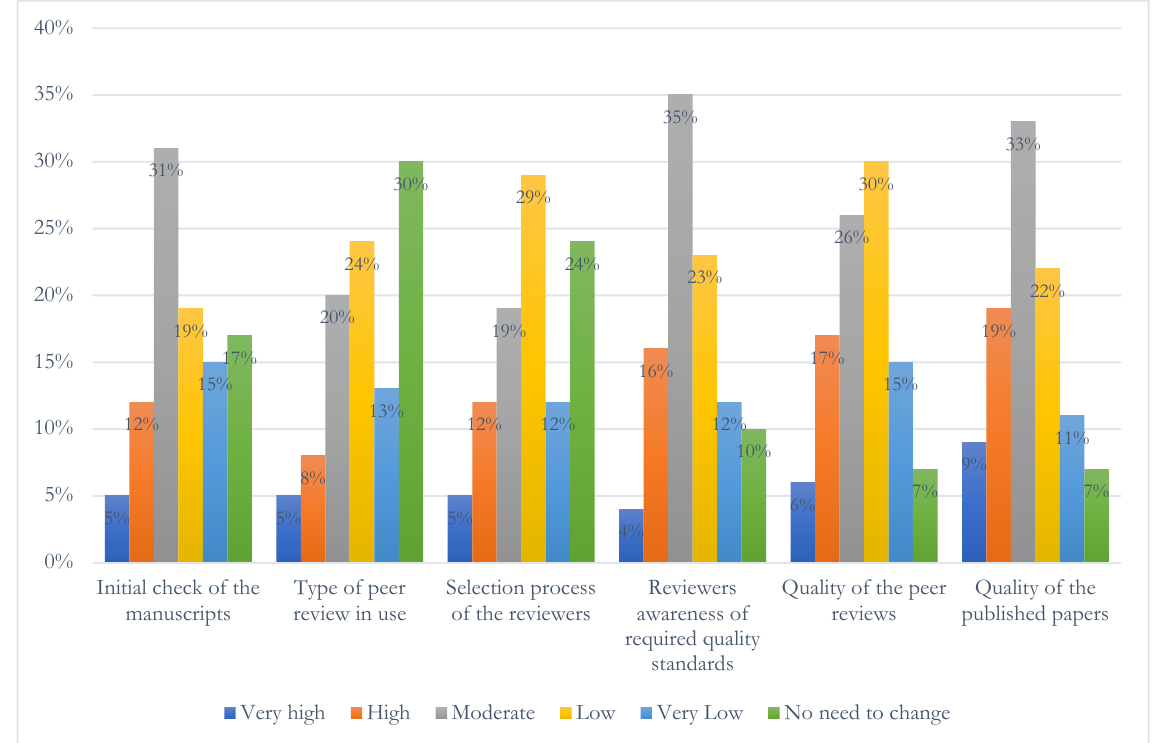
Figure 1. Respondents’ perceptions of need for improvement in particular quality assessment processes (q32, n = 214, skipped = 44). Table 3. List of independent and dependent variables for bivariate